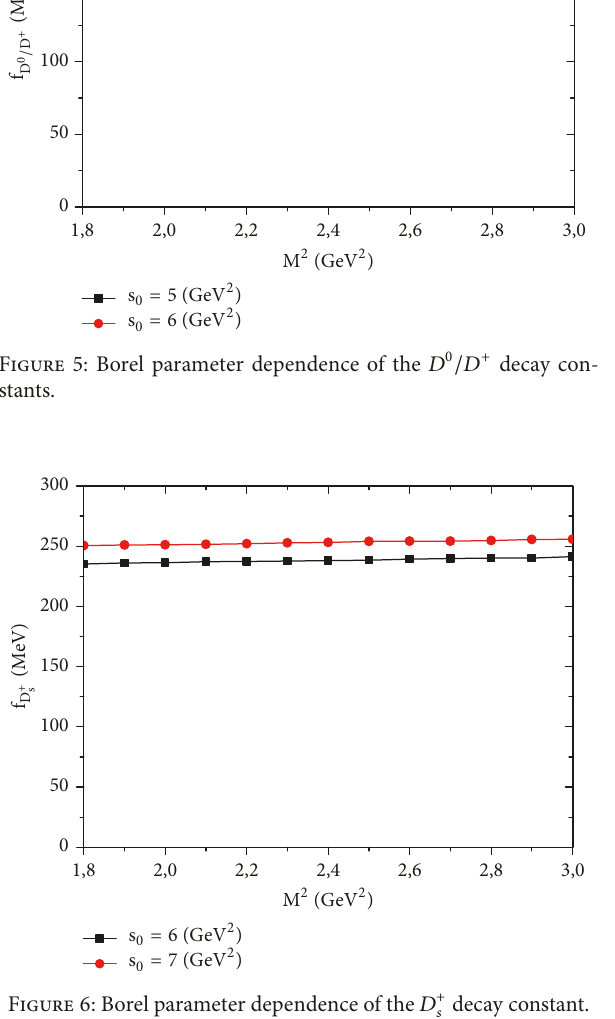
Figure 6: Borel parameter dependence of the 𝐷 + 푠 decay constant.